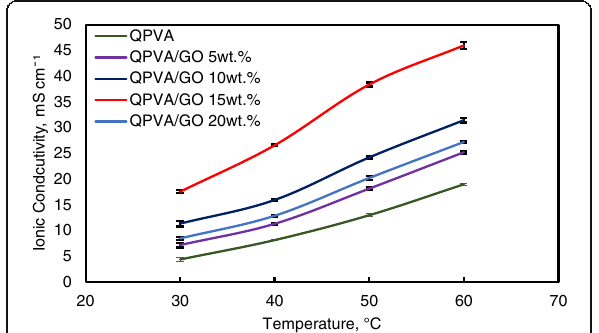
Fig. 13 Ethanol uptakes and Ethanol permeability of QPVA membrane and QPVA/GO composite membrane at 30